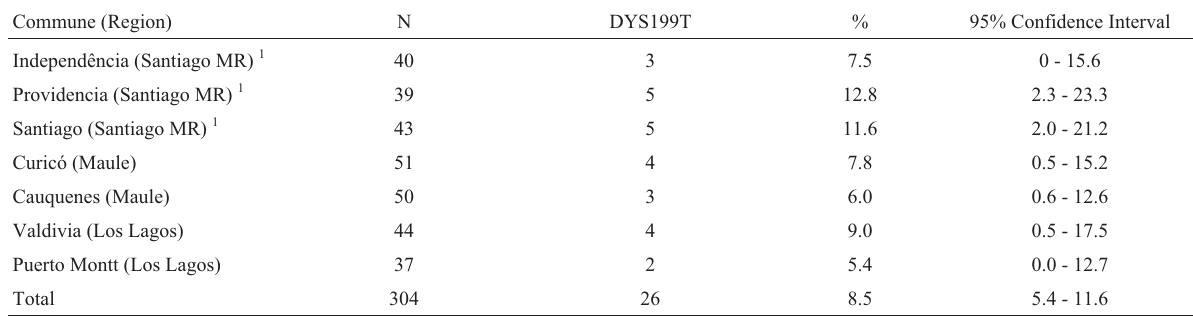
Table 3 - DYS199T allele frequency in the seven Chilean communes Commune (Region)